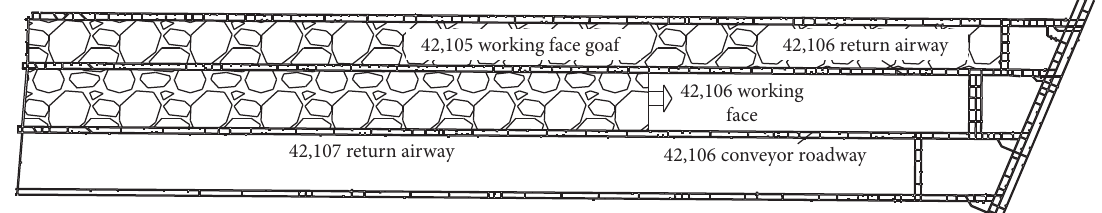
Figure 8: Layout of 42,106 working